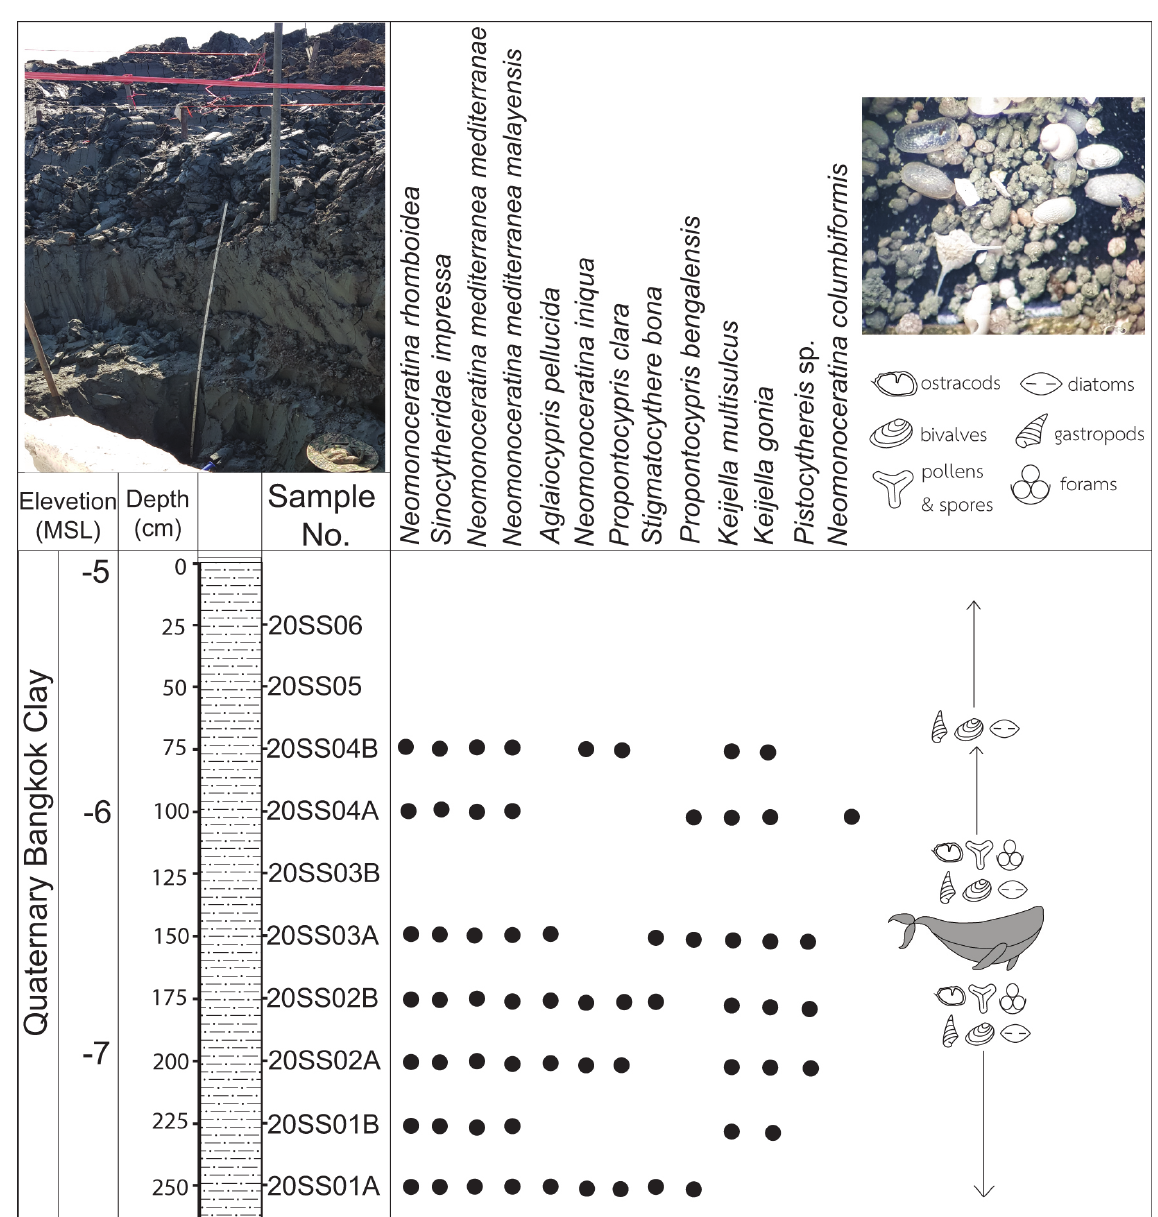
Fig. 4. Distribution of Holocene ostracods below and above the whale skeleton level at the whale-fall excavation site in Samut Sakhon Province, north of Gulf of